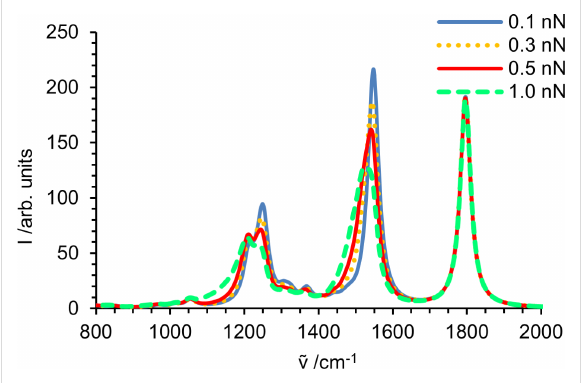
Figure 3: Fingerprint region of a simulated spectrum of an N -propyl- propanamide solid sample at 0.1, 0.3, 0.5 and 1.0 nN mean force per polymer